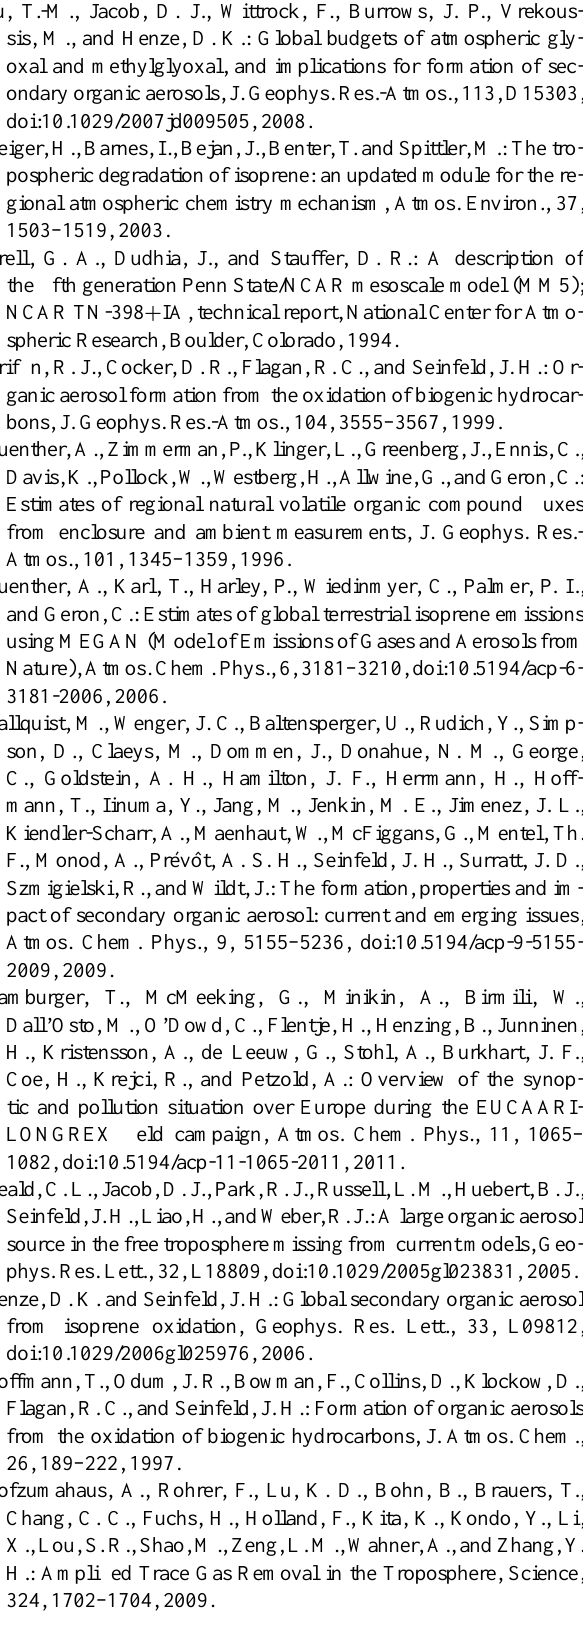
ALGORITHM E4, Acm T. Math. Software., 7, 369–383,